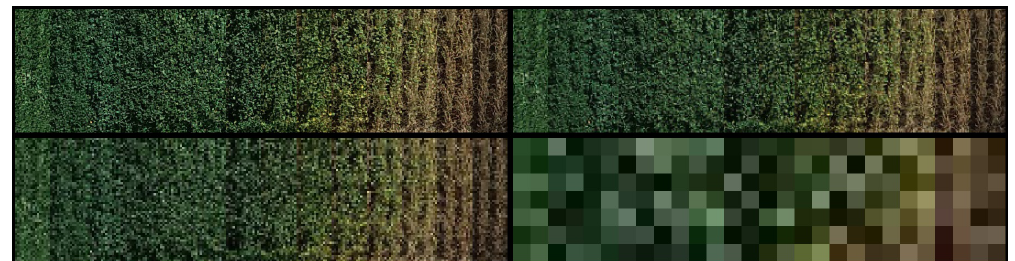
Figure 3. Time series of plot images with resolution of 25 mm/px ( top left ), 50 mm/px ( top right ), 100 mm/px ( bottom left ), and 750 mm/px ( bottom right ).